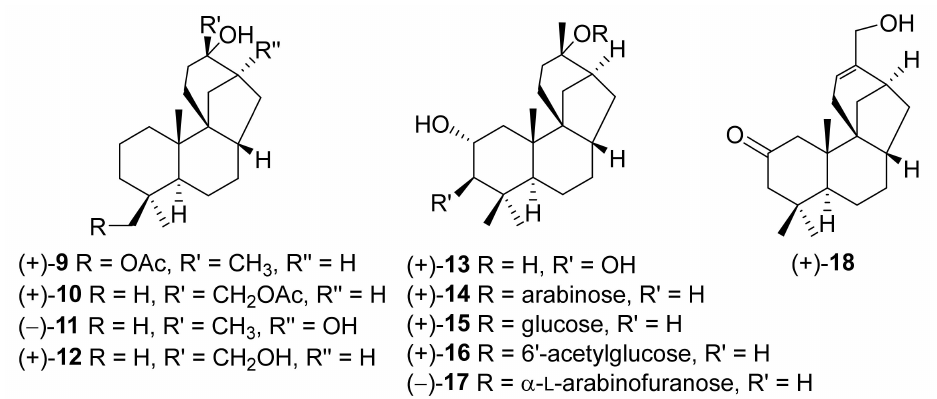
Figure 8. S. maritima stemodane diterpenoids 9 – 18